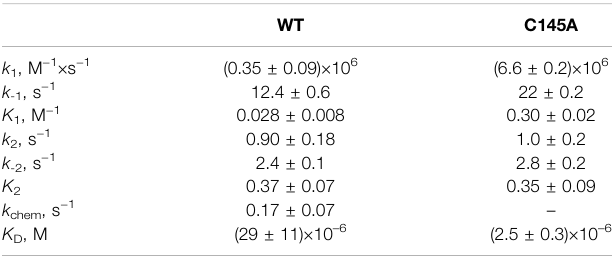
Frontiers in Pharmacology |